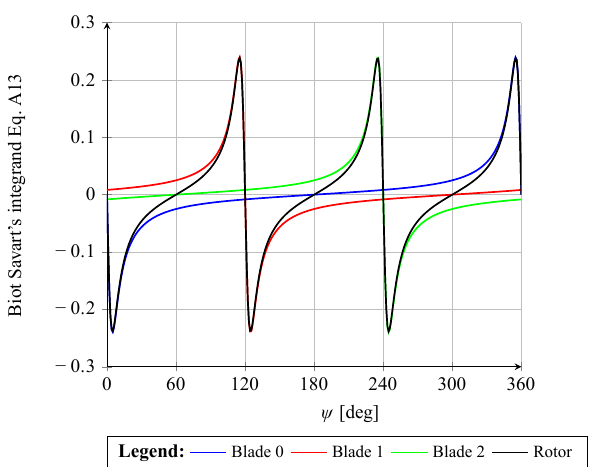
Figure A1. Biot–Savart’s integrand from Eq. (A13) for each blade for a three-bladed rotor (blades located at ψ = 0, 120 and 240 ◦ ). The sum of all the blade contributions is shown in black. At the bi- sectrix between two consecutive blades ( ψ = 60, 180 and 300 ◦ ), the Biot–Savart’s integrand from Eq. (A13) is zero. The blade-induced velocity at those points is consequently also